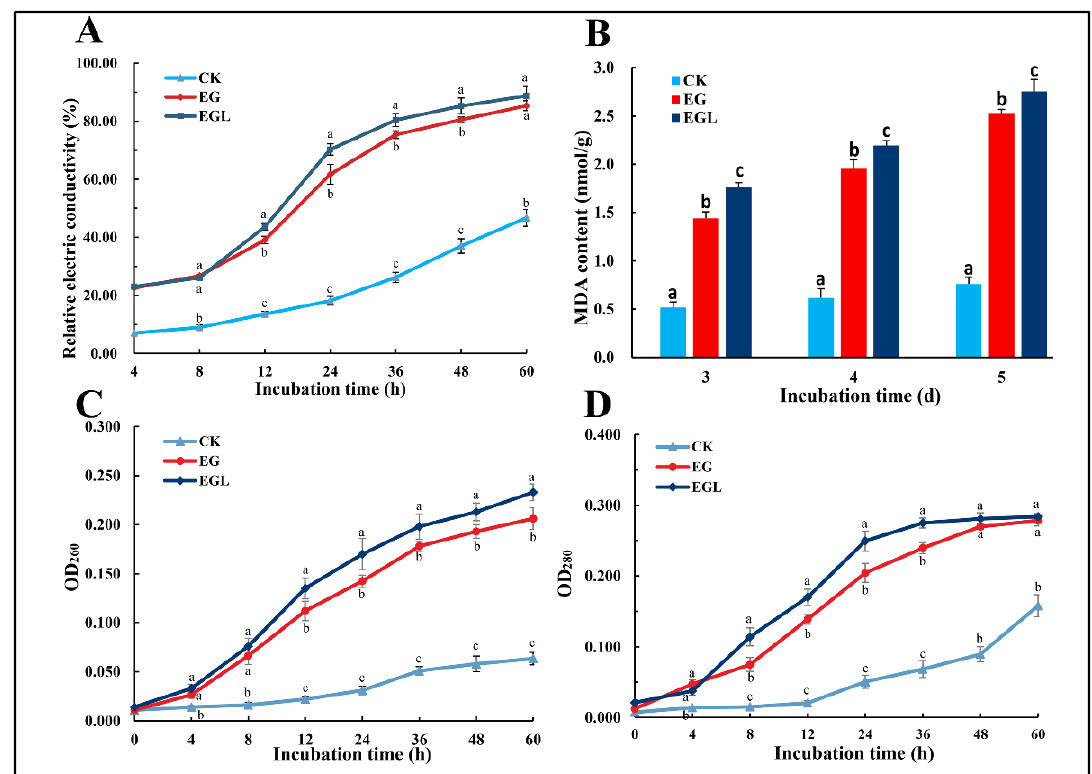
Figure 5. Influence of the nanoemulsion (at a eugenol concentration of 160 µ g/mL) on the extracellular conductivity ( A ), lipid peroxidation ( B ), leakage of nucleic acid ( C ), and protein ( D ) of P. italicum . Data are shown as mean ± SD from three replications and different letters represent a significant difference ( p < 0.05).